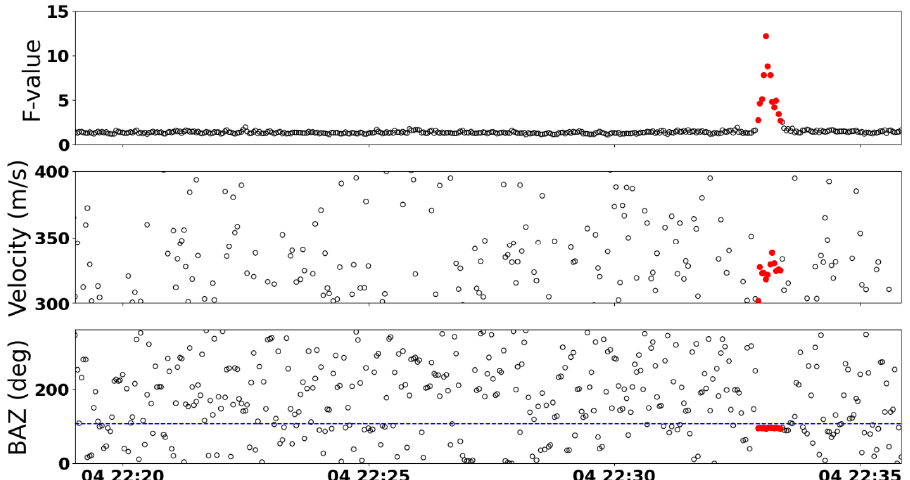
Figure 12. FK analysis results indicating the detection of a strong coherent signal, which was nominally consistent with a reported bolide/fireball identified by the GOES satellites at 22:19:01 UTC on 4 April 2019 and was ~300 km from OSU1. The blue dashed line marks the back azimuth angle of the reported bolide. Closed (red) markers indicate periods with high coherence (i.e., high F-value) and an acoustic trace velocity.